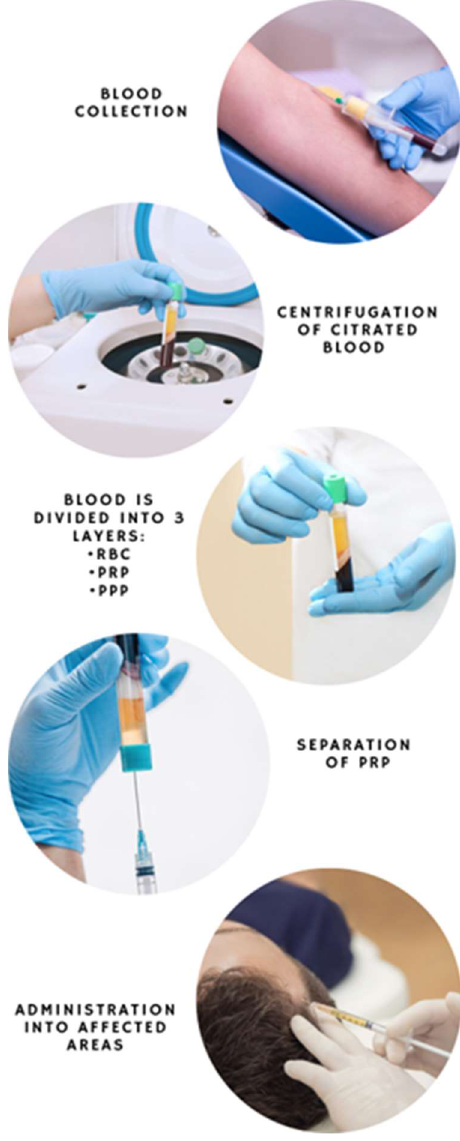
Figure 2. Centrifugation and platelet-rich plasma separation.